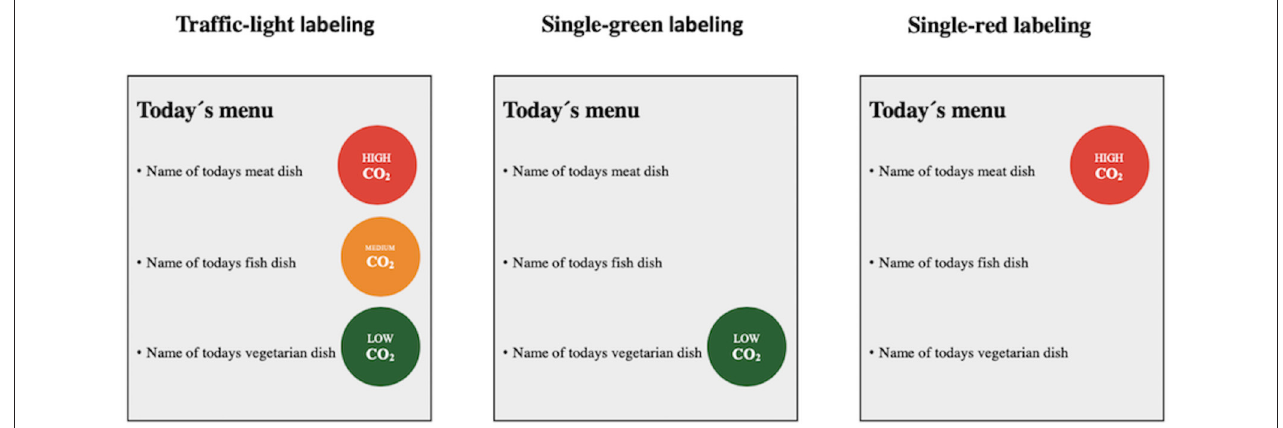
FIGURE 1 | The three different labeling systems used in the